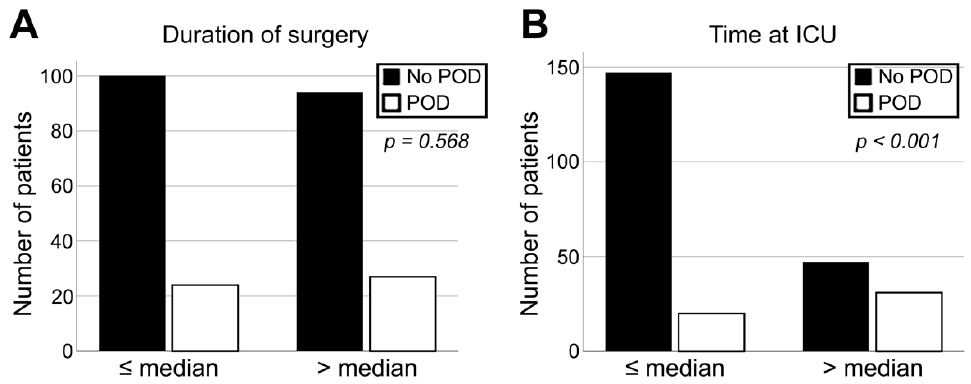
Figure 2. Impact of duration of surgery ( A ) as well as time at intensive care unit (ICU) ( B ) on occurrence of POD.